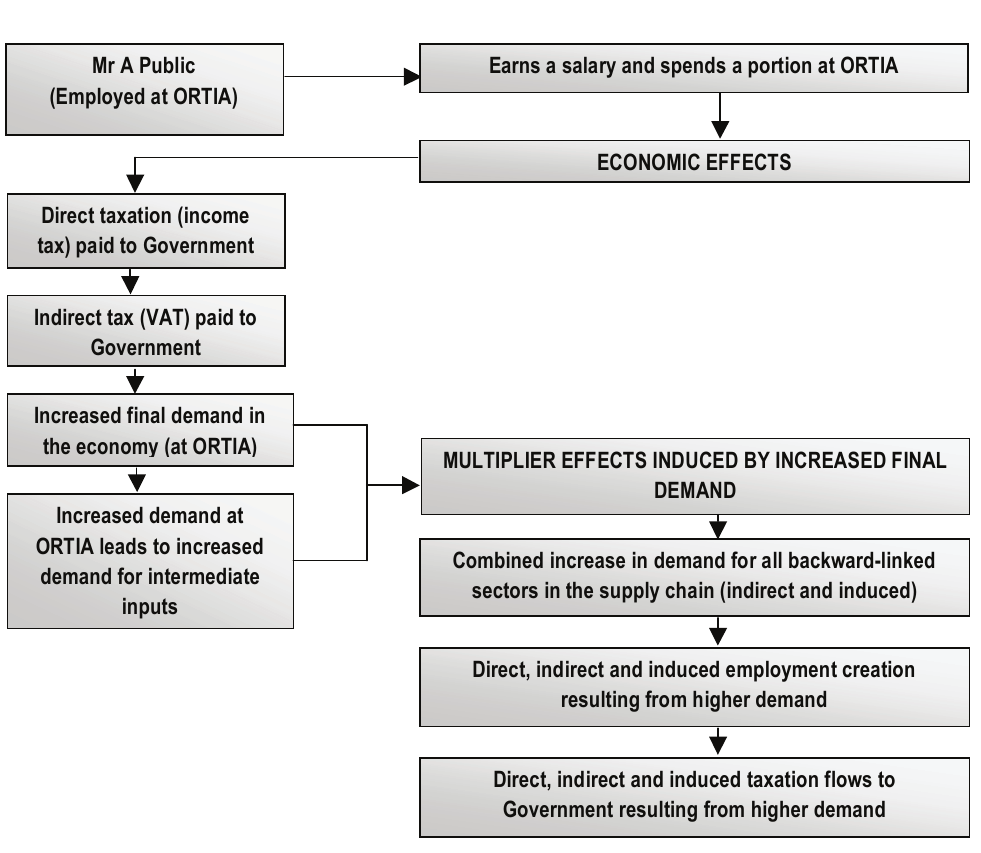
Figure 1: Example of the economic multiplier